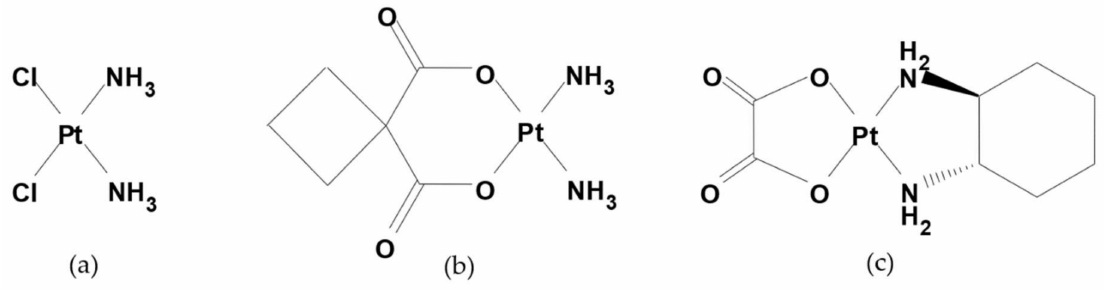
Figure 1. Chemical structure of ( a ) Cisplatin, ( b ) Carboplatin and ( c )